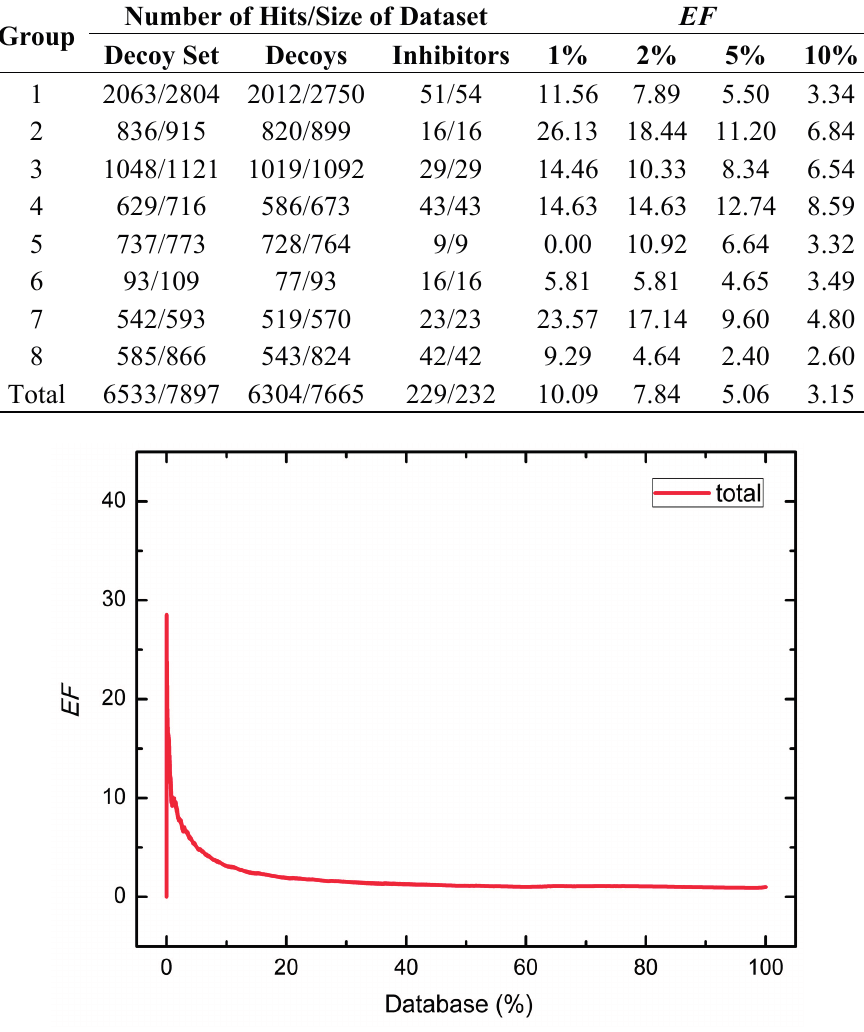
Table 3. Enrichment factor ( EF ) values of each decoy dataset.